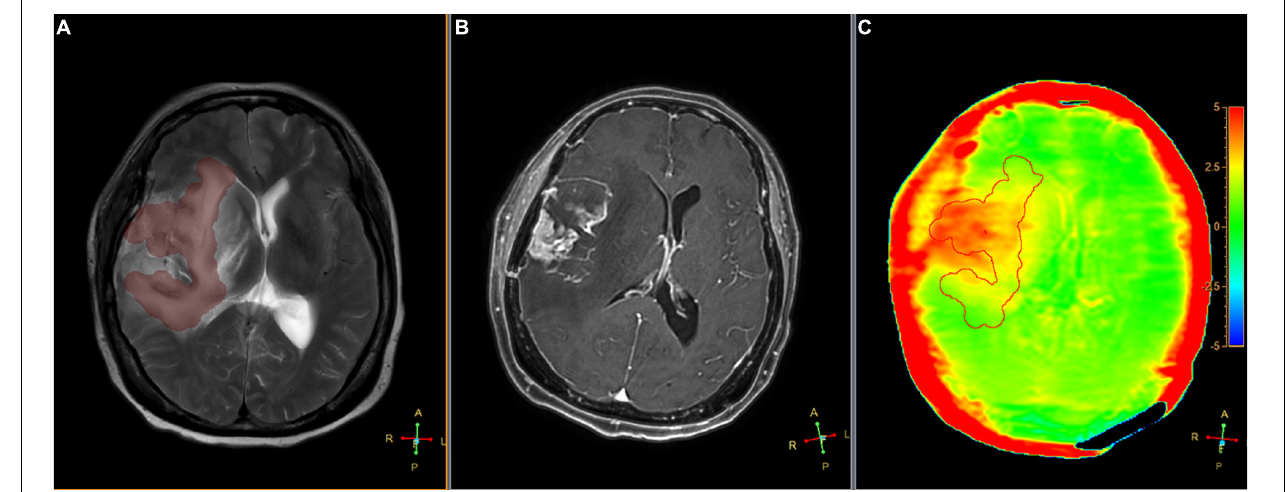
FIGURE 5 | Segmented peritumoral high signal intensity areas and the peritumoral areas in a 63-year-old male with gliomas (Grade IV) overlaid onto coregistered T2W (A) , Gd-T1W (B) , and APTw (C) images (SENSE AF = 1.6). The APT edema was 2.47%.